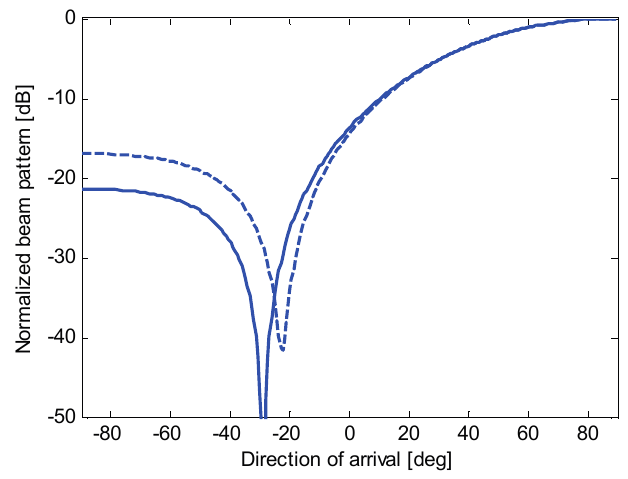
Figure 15. Nominal beam pattern (solid line) and actual beam pattern (dashed line) for oversteered beamforming with Taylor’s weights applied to an end-fire array of eight microphones.